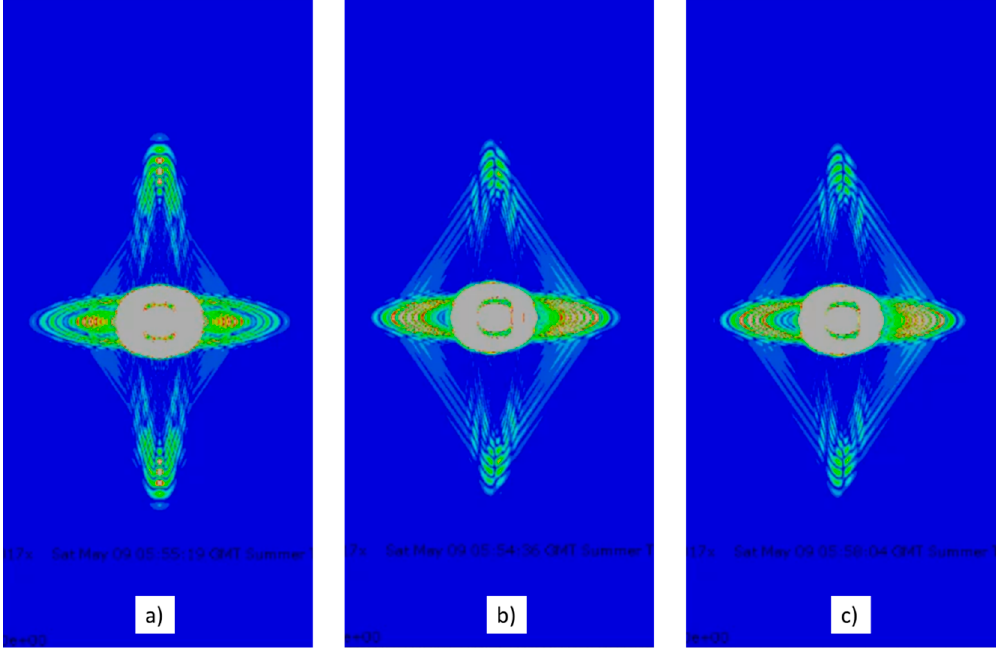
Figure 16. Images captured at 20 µs after the beginning of the simulation of the waveforms propagated on a composite material when they are generated by two PWAS and the emission is delayed ( a ) 0 µs, ( b ) 1.6 µs, and ( c ) 2.0 µs.